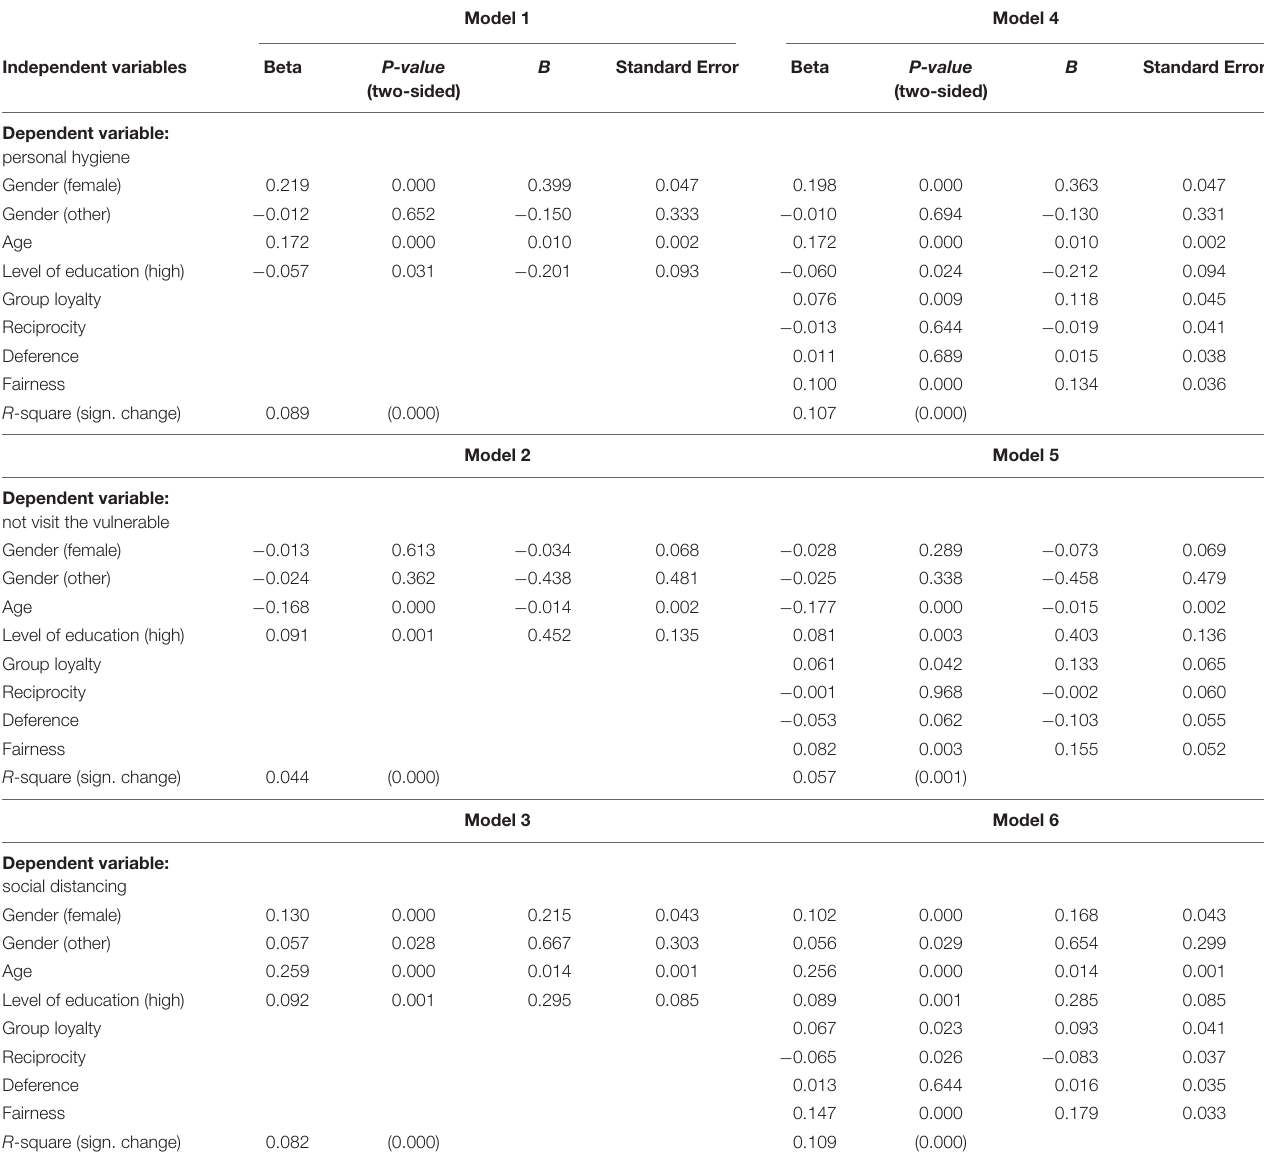
TABLE 10 | Coefficients of regression models predicting compliance to national Corona measures (Study